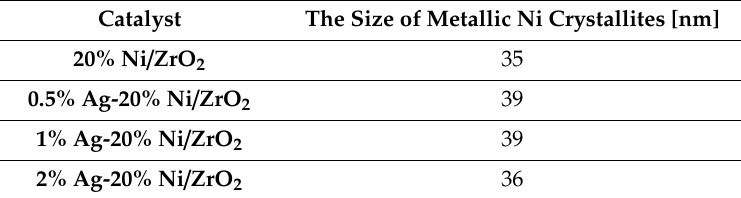
Table 9. The size of the metallic nickel crystallites calculated from the XRD measurements of spent Ni catalysts (after catalytic tests performed in the oxy-steam reforming of LNG